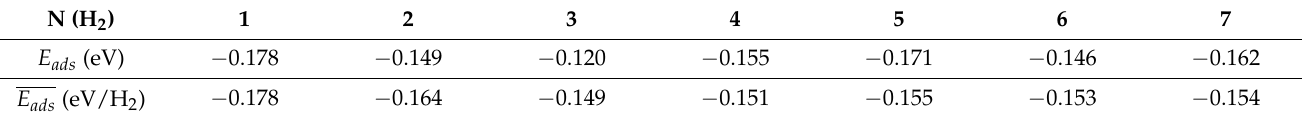
Table 6. Hydrogen adsorption energy and average adsorption energy of